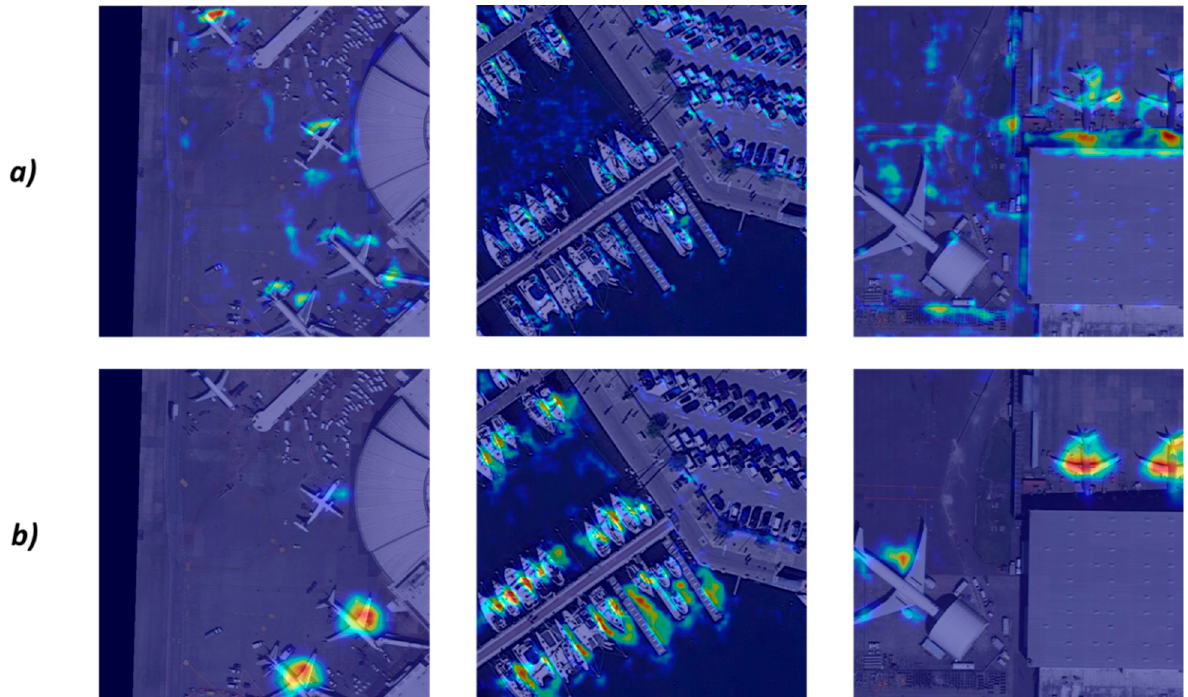
Figure 4. Comparison of class activation mapping. ( a ) Input class activation mapping. ( b ) Class activation mapping after background filtering module.